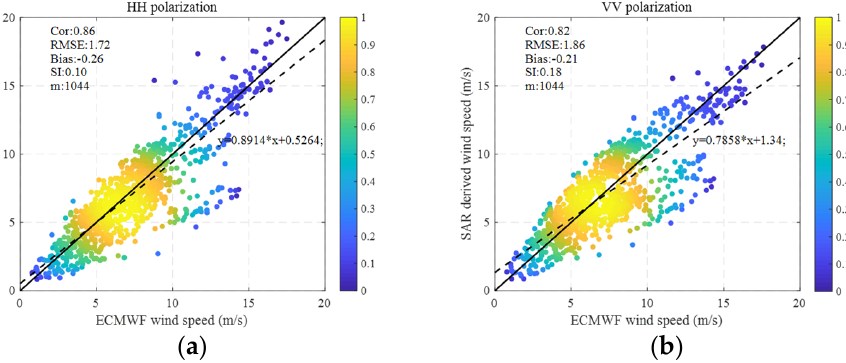
Figure 10. Wind speed retrieval precision for GF-3 SAR HH and VV polarization. The SAR-derived wind speed was compared with on-site wind speed provided by ECMWF: ( a ) CMOD5.N+PR; ( b ) CMOD5.N. The color represents the density of scatter points.